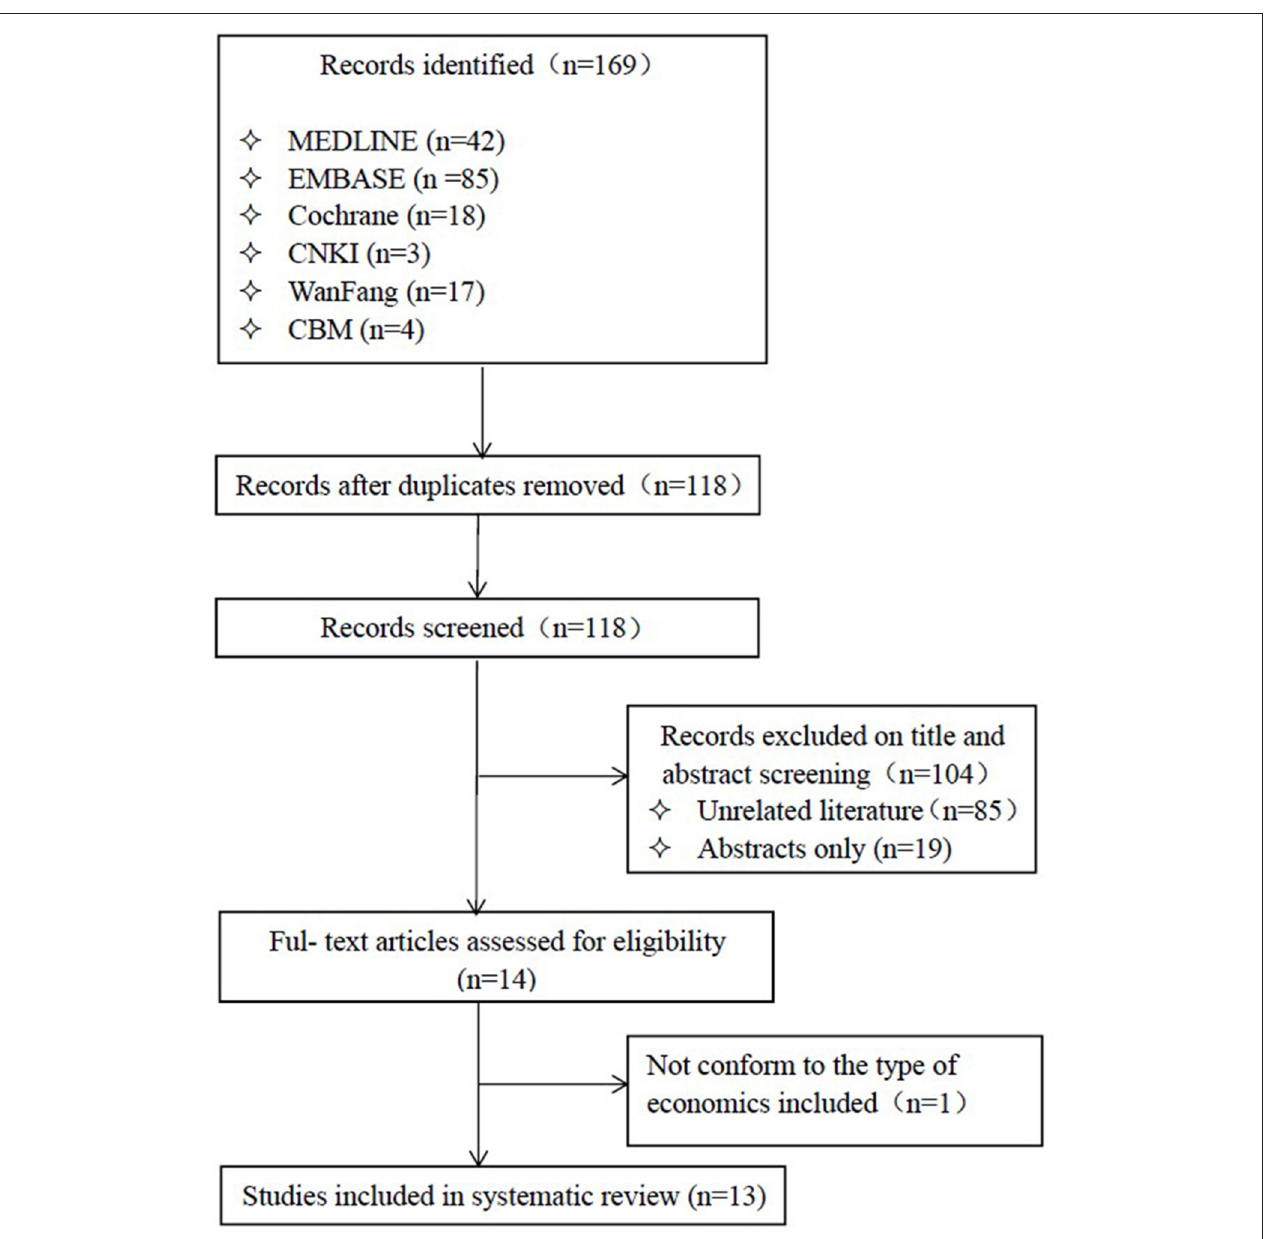
FIGURE 1 | Study selection